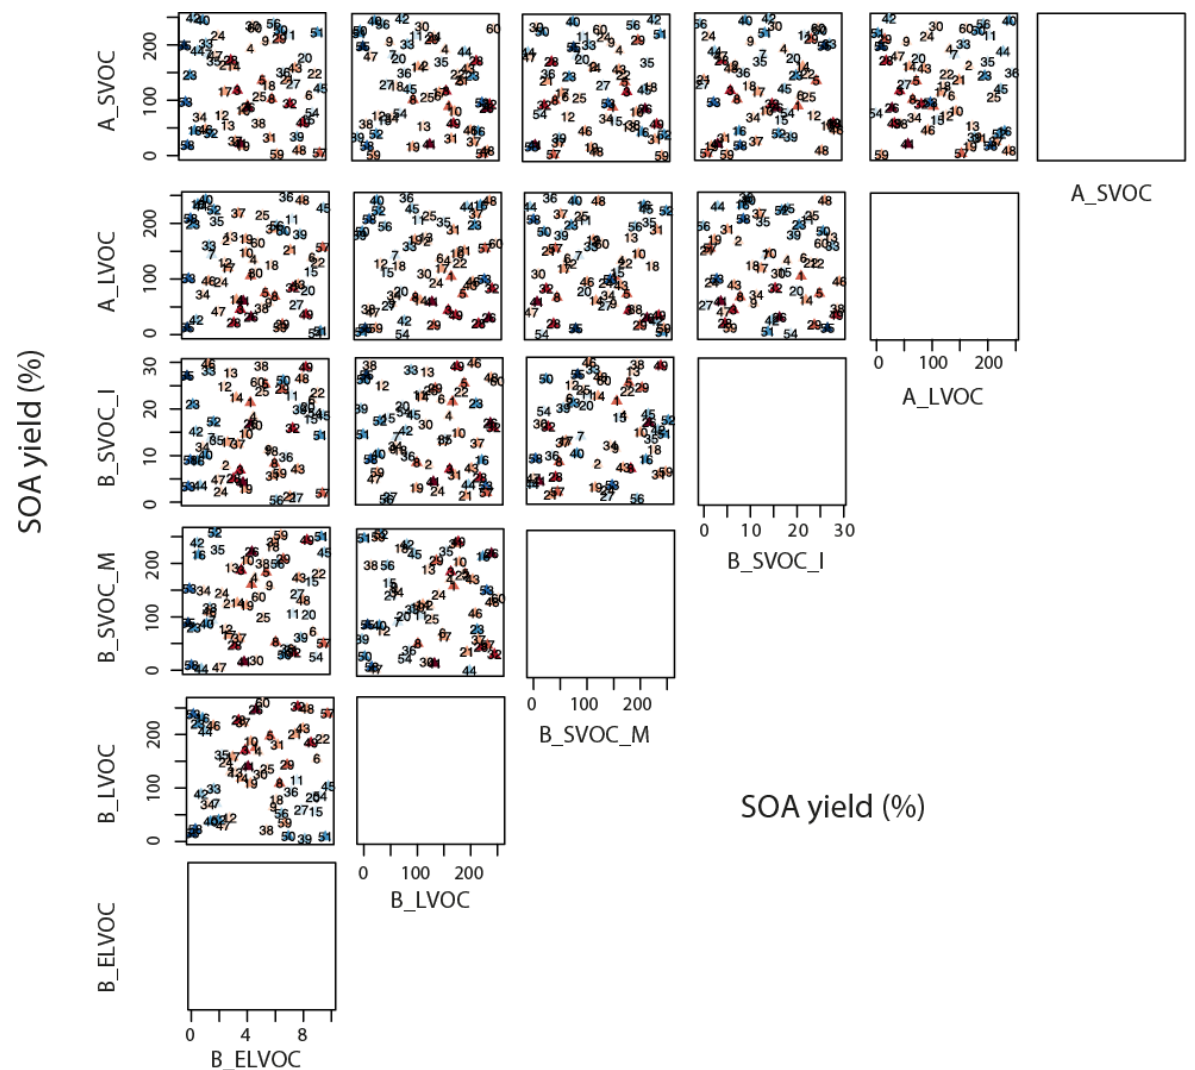
Figure A3. Taylor skill score for model simulations against N3 observations across the 6-D parameter space. The x and y axes for a subplot show the total range of reaction yields (%) over which of the two parameters (as indicated by the plot labels at the top and right for each subplot respectively) is perturbed in the ensemble. Each triangle in a subplot represents a simulation (labelled 1–60), and the color of the triangle indicates its Taylor skill score for N3. Darker shades of blue indicate low/poor Taylor skill score and darker shades of red represent high/good Taylor skill score. Note the axis for B_ELVOC shows the scaling factor for B_ELVOC yields. Axes for the rest show the corresponding ox-VOC